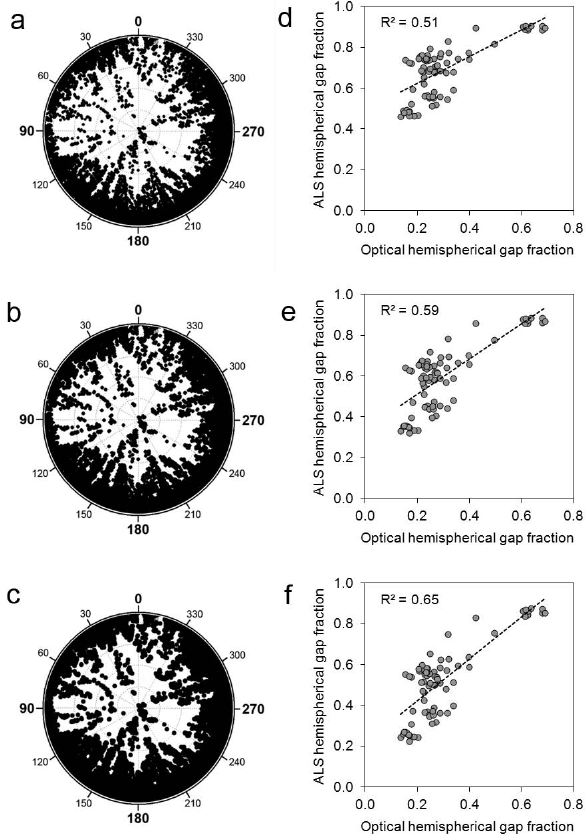
Fig. 2. Effect of projected ALS return size on the relationship be- tween observed and predicted gap fractions. The projected circle size of synthetic image examples ( a , b , c ) and corresponding rela- tionships ( d , e , f ) is expressed as the fraction between the diameter of each ALS return and the diameter of the image: 0.0137 ( a , d ), 0.0176 ( b , e ), and 0.0215 ( c , f ).